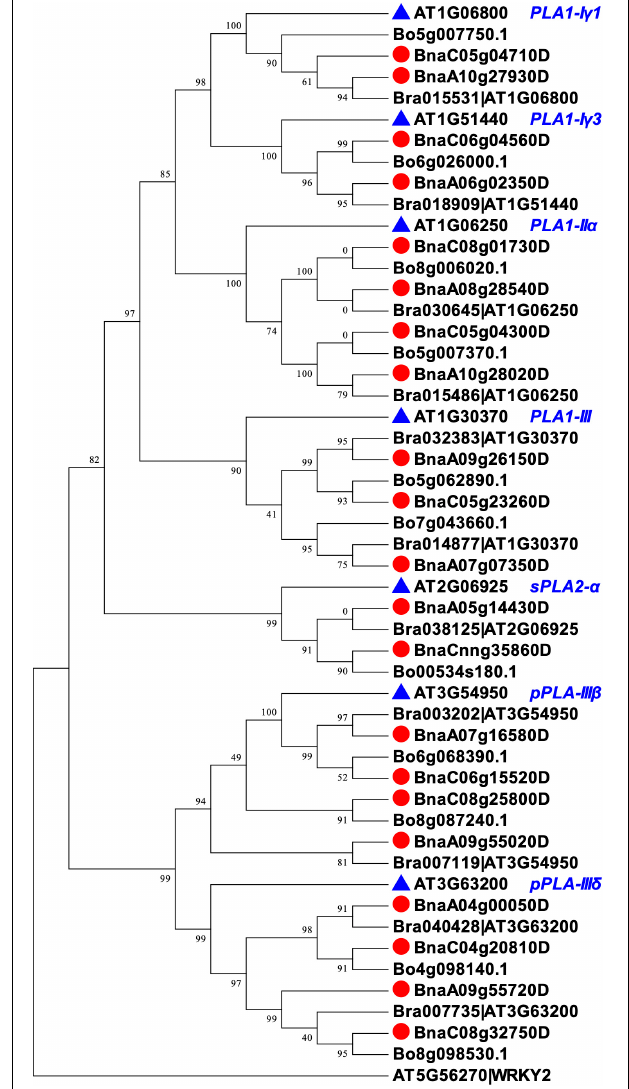
FIGURE 3 | Phylogenic relationships of PLAs in Arabidopsis and Brassica species ( B. rapa , B. oleracea, and B. napus ). The phylogenic tree was constructed with fasttree using PLA peptide sequences aligned by MUSCEL in Mega7. Arabidopsis WKRY2 (AT5G56270) was used as the root. Each PLA encoding gene in B. rapa was followed with an Arabidopsis gene ID in the genome annotation, which was kept in the phylogenic tree to confirm the clustering of the